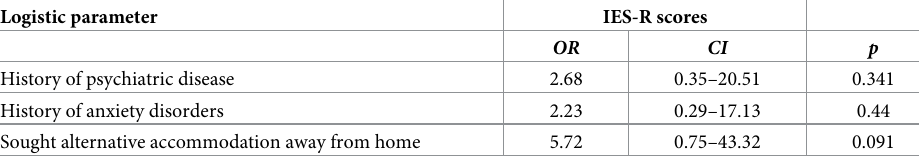
Table 3. Factors without an association with IES-R scores.